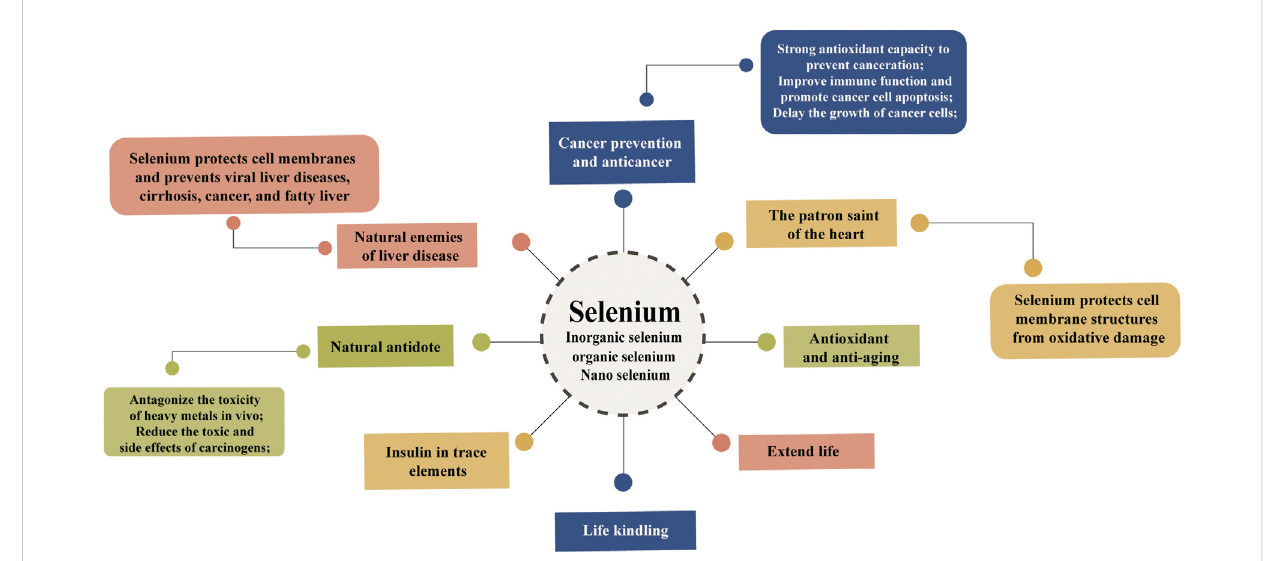
The main functions of selenium in organisms. Selenium plays an important role in the growth of organisms. It has strong antioxidant capacity and is used as a cancer prevention and anticancer agent as well as an antiaging agent. Selenium, which protects cell membrane structures, has been called the enemy of liver disease and the patron saint of the heart. At the same time, selenium can antagonize the toxicity of heavy metals in vivo and extend